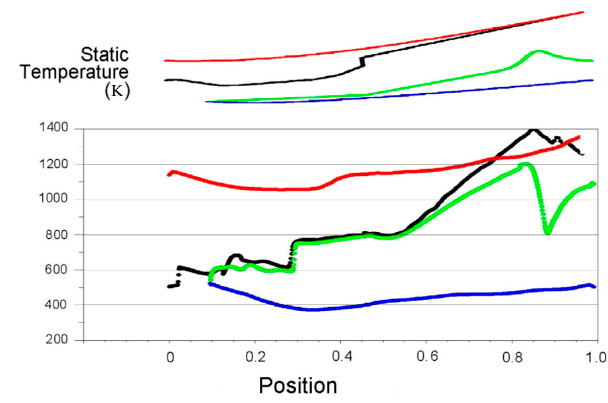
Figure 28. Static temperature distribution on the walls of the engine channels.